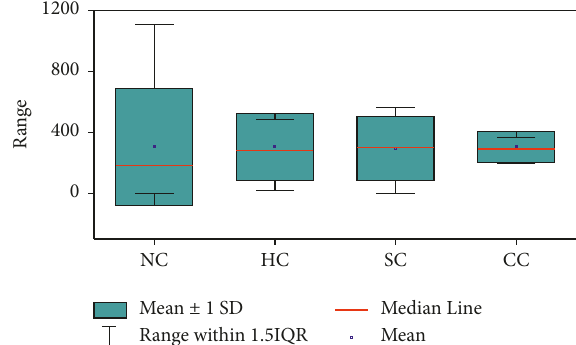
Figure 12: Analysis of bus headway